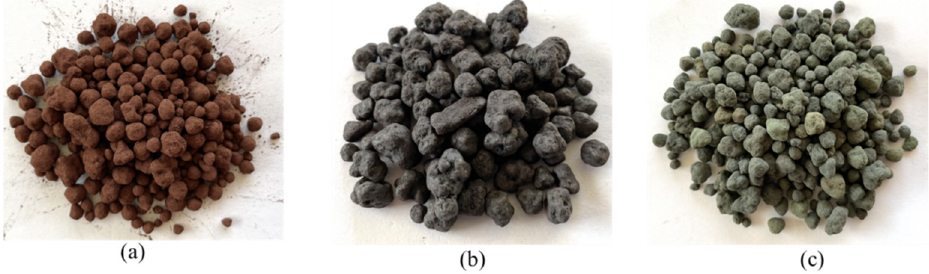
Figure 2. Dried Mn oxide pellets ( a ), sintered Mn Oxide pellets ( b ), and pellets reduced by hydrogen ( c